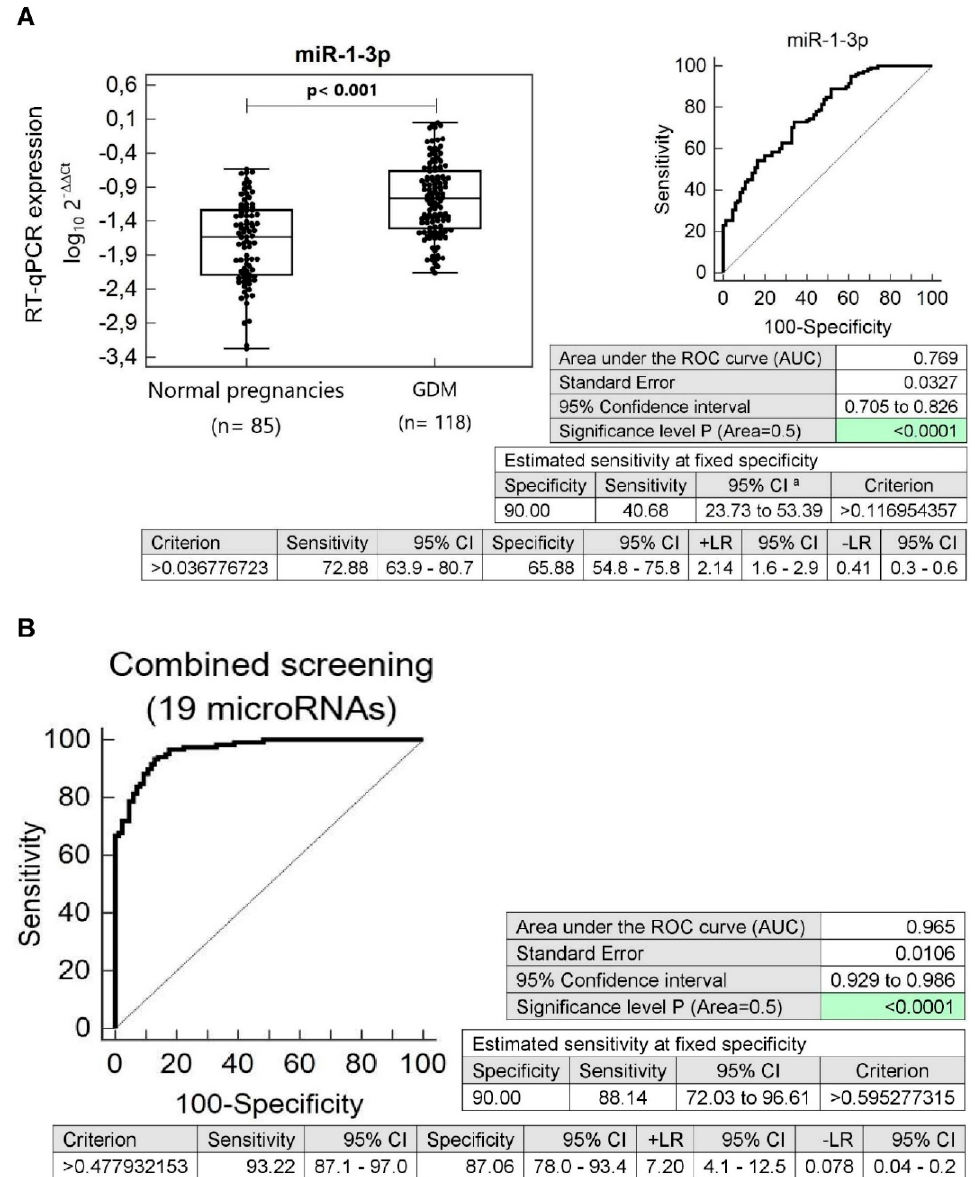
Figure 2. Aberrant microRNA expression profile in children descending from GDM complicated pregnancies irrespective of the clinical findings (overweight / obesity, prehypertension / hypertension, and / or valve problems and heart defects). ( A ) Upregulation of miR-1-3p was observed in children descending from GDM complicated pregnancies when the comparison to the controls irrespective of the clinical findings was performed. Concerning individual microRNAs, miR-1-3p showed the highest accuracy for the identification of children at a higher risk of later development of diabetes mellitus and / or cardiovascular / cerebrovascular diseases. ( B ) Combined screening of microRNAs in the identification of children prenatally exposed to GDM at an increased risk of later development of